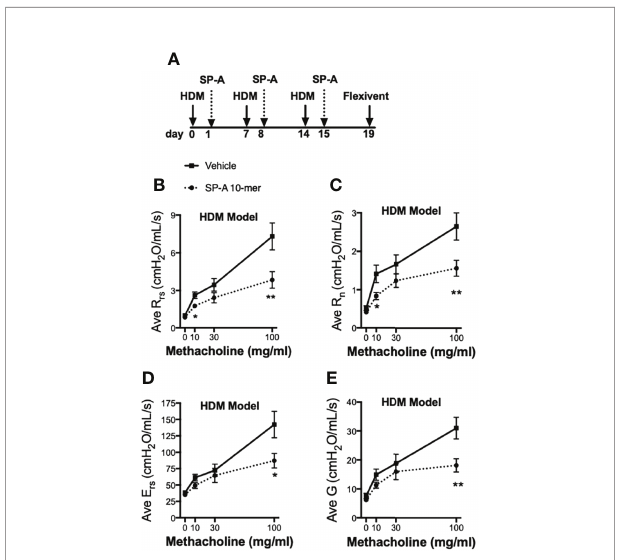
FIGURE 4 | HDM-challenged WT mice treated with SP-A peptides have reduced sensitivity to methacholine challenge. (A) WT male mice challenged intra-nasally with HDM on days 0, 7, and 14. On days 1, 8 and 15 mice were divided into groups and given either vehicle or SP-A peptides (10-mer, 25 m g/ ml, ~1 mg/kg body weight) via oropharyngeal instillation. On day 19, pulmonary function tests during a methacholine challenge were performed while mice were under anesthesia. (B) Total airways resistance (Rrs), (C) Newtonian resistance (Rn), (D) total airways Elastance (Ers) and (E) tissue damping (G) were assessed by fl exivent. Data graphed are mean +/- SEM. n = 12,12, *p < 0.05, **p < 0.01 by t-test at each indicated dose.